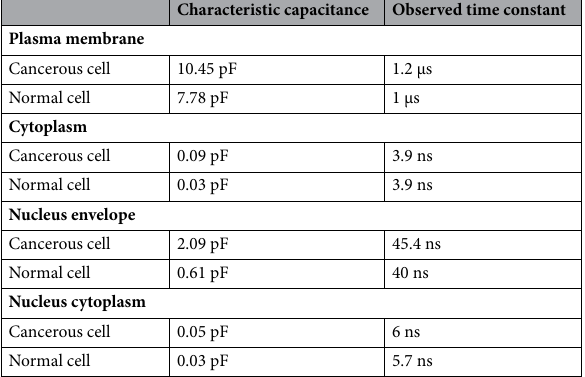
Table 1. Characteristic capacitance and observed charging/discharging time